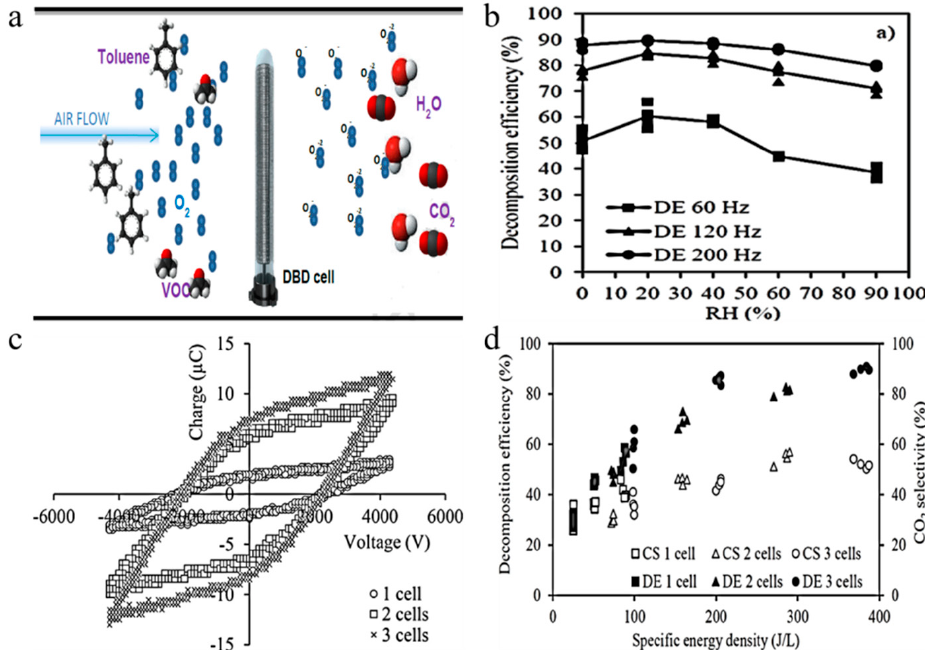
Figure 12. ( a ) graphical abstract; ( b ) the impact of relative humidity on decomposition efficiency at different frequencies; ( c ) Lissajous figures of different discharge regions; ( d ) effect of specific energy density on CO 2 selectivity and decomposition efficiency. Reproduced with permission from [137]; Copyright Elsevier, 2018.